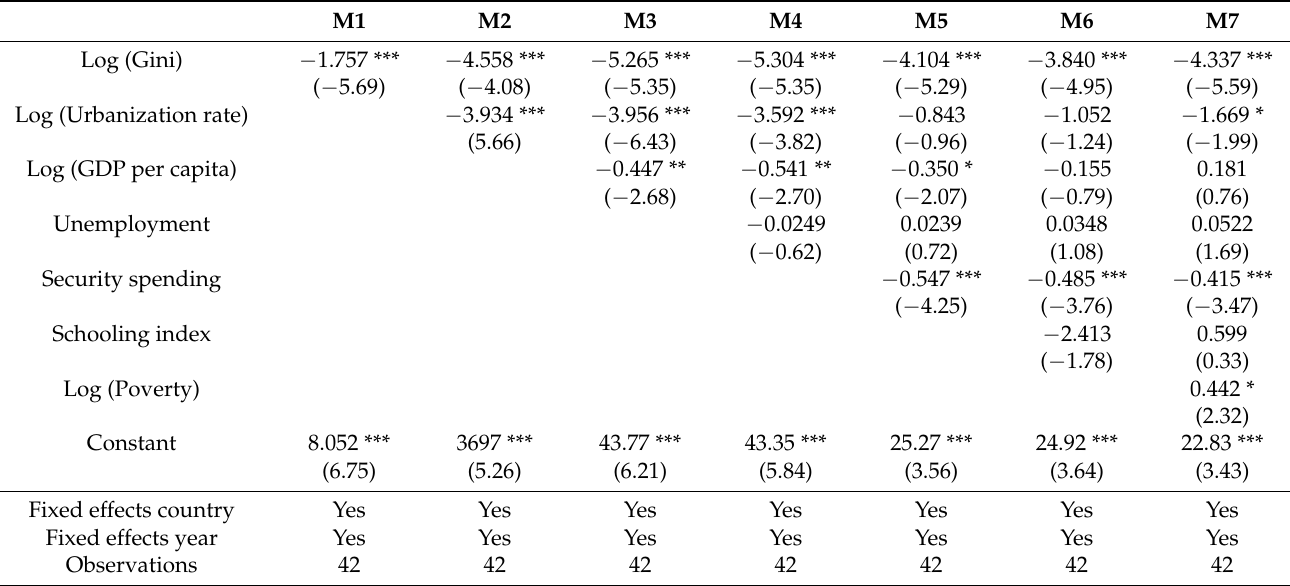
Table 5. Baseline regression of the GLS model with a control variable for